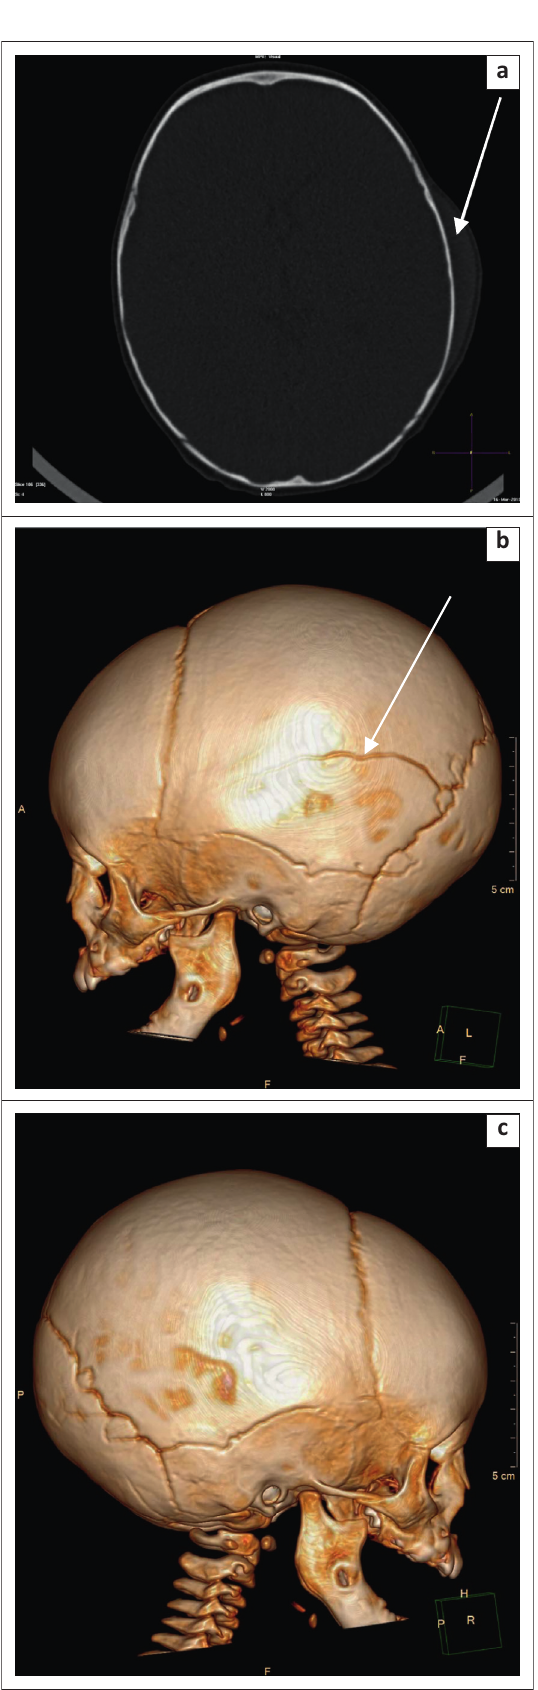
FIGURE 1: (a) An 8 month old infant fell off the bed and presented with left sided scalp swelling. Axial CT bony algorithm demonstrated left parietal scalp swelling (white arrow). No distinct fracture was visualised in this plane; (b) 3D reconstruction demonstrated a linear left parietal fracture (white arrow); (c) 3D reconstruction of the non-fractured side revealed normal sutures.